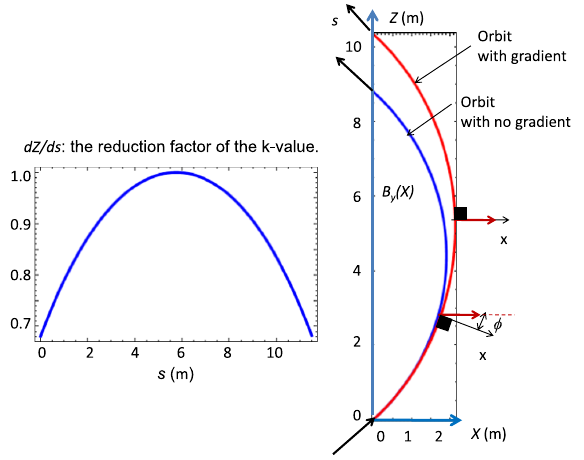
FIG. 8. Orbits of an on-momentum (ideal) particle in the bending magnet with linear field gradient for the case of B ρ ¼ 9 ½ Tm (cid:2) or V ¼ 38 MV discussed in Sec. IV D, which are obtained by numerically solving equations of motion given in Appendix B.